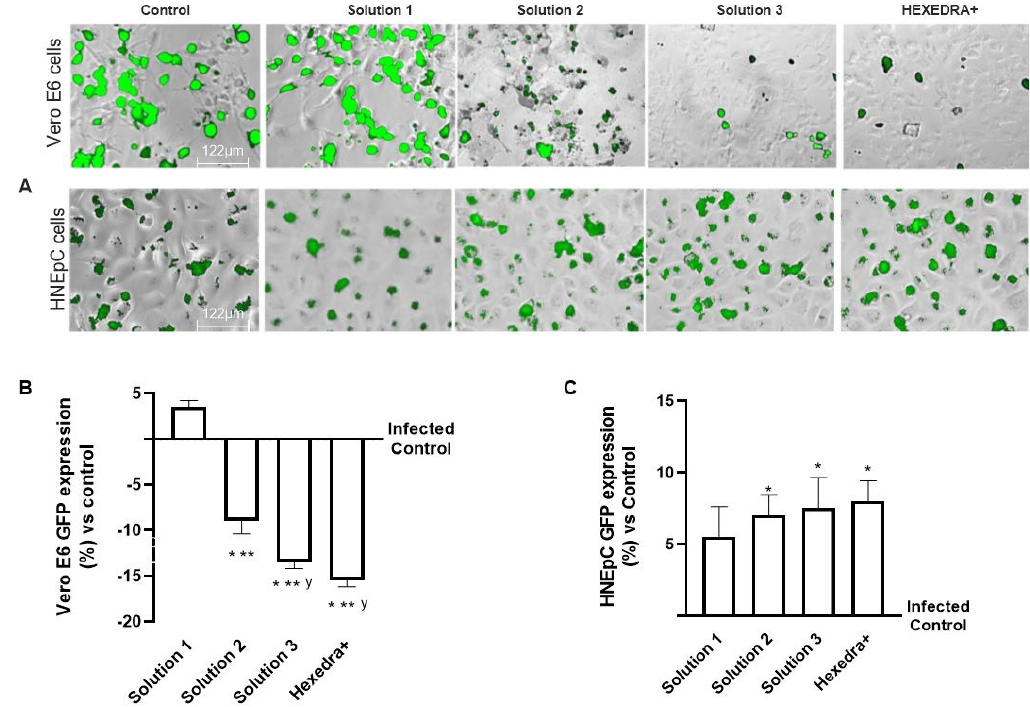
Figure 4. Analysis of infection of Vero E6 and HNEpC cells with VSV-based pseudovirus SARS- CoV-2 (MOI 0.1) pre-treated with the different UA-based formulations. The images reported were an example of each stimulation for GFP fluorescence expression obtained at 40× magnification by Paula (Leica DM1000). The positive cells were counted analyzing GFP expression in cells by the Image J software and the results were expressed as mean ± SD (%) compared to infected control cells (0 line) of four independent experiments. The abbreviations are the same reported in Figure 2. * p < 0.05 vs. infected control; ** p < 0.05 vs. Solution 1; y p < 0.05 vs. Solution 2.